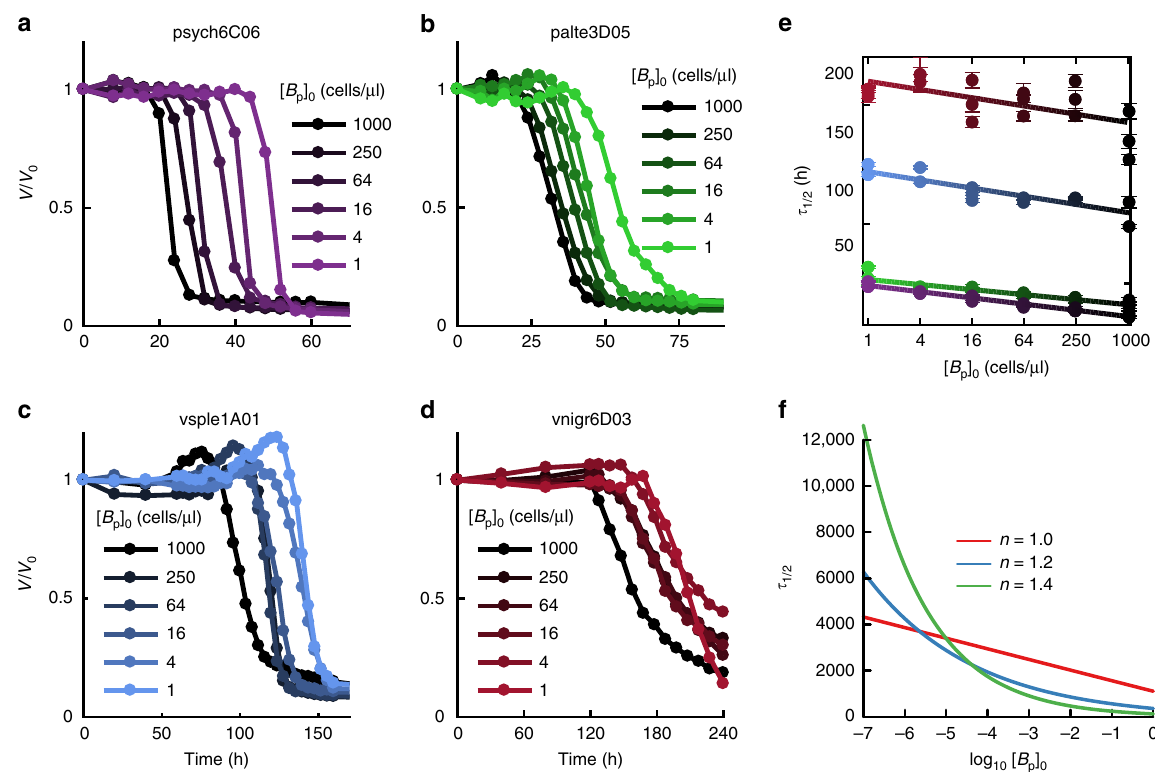
Fig. 2 Effect of cell initial cell concentration on particle degradation kinetics. a – d Mean particle volume over time for primary degraders, over a range of initial inoculum concentrations, [ B p ] 0 . e Linear dependency between log[ B p ] 0 and the particle half-life as predicted by Eq. (1) validates the simple model of degradation without cooperativity. f Prediction for log [ B p ] 0 vs. half-life based on models with ( n > 1) or without cooperativity ( n = 1) for simulation parameters a 0 = 0.01, β = 0.005, and R 0 = 10